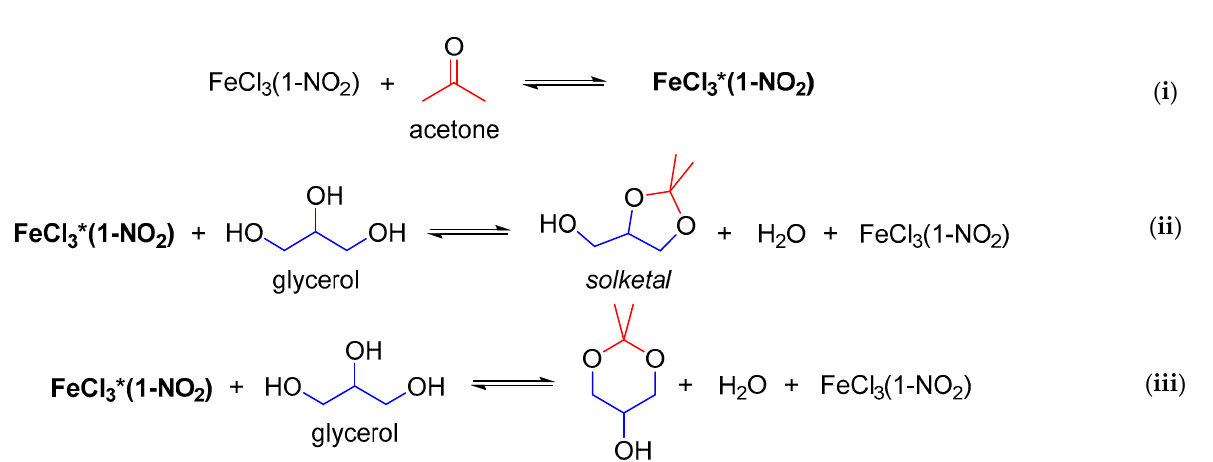
Scheme 2. Glycerol ketalization reaction scheme: ( i ) coordination of acetone to Fe(III) complex; ( ii ) glycerol ketalization to solketal; and ( iii ) glycerol ketalization to the by-product.